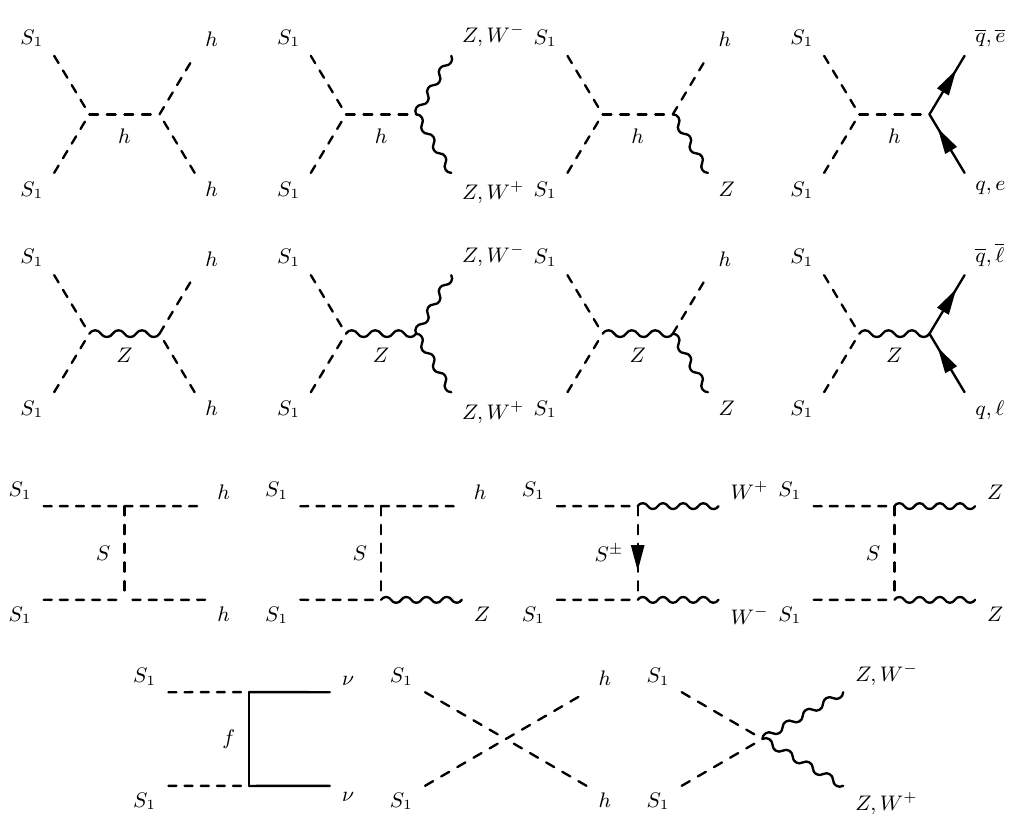
Figure 17 . Annihilation diagrams for scalar DM. These coincide with the ones contributing to S 1 and S ( i = 2 , 3 , 4 ) co-annihilation, after making the replacement of one initial S i